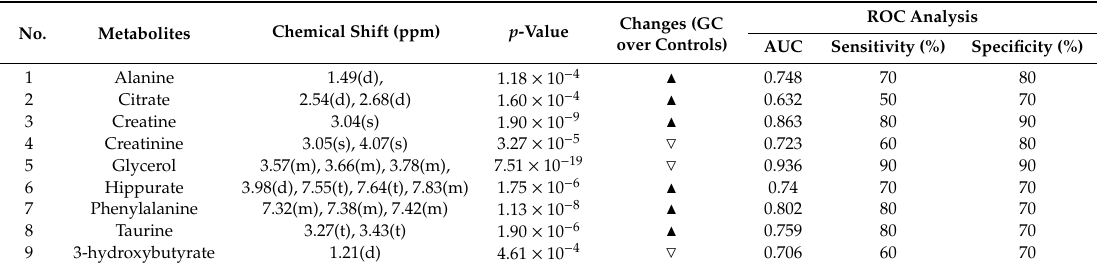
Table 2. Identified metabolites, with changes in their levels in gastric cancer (GC) and receiver operating characteristic (ROC) analysis results.